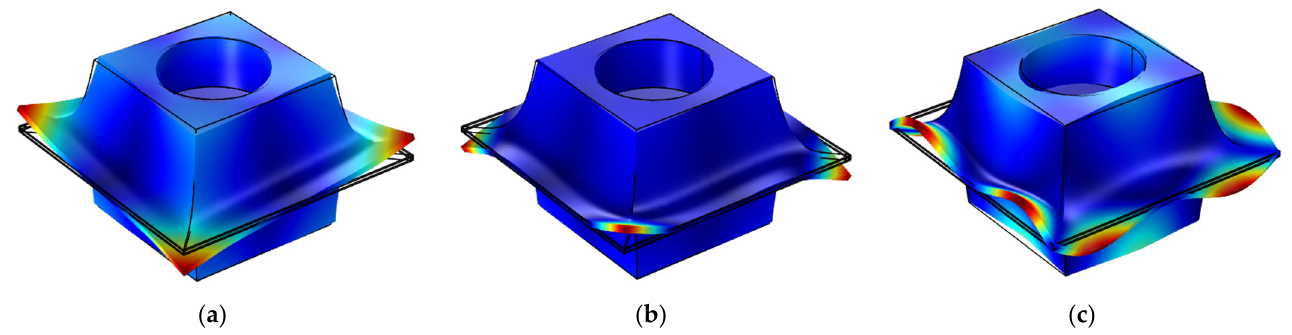
Figure 9. Modal maps of the natural frequency: ( a ) first natural frequency; ( b ) fifth natural frequency; ( c ) tenth natural frequency.